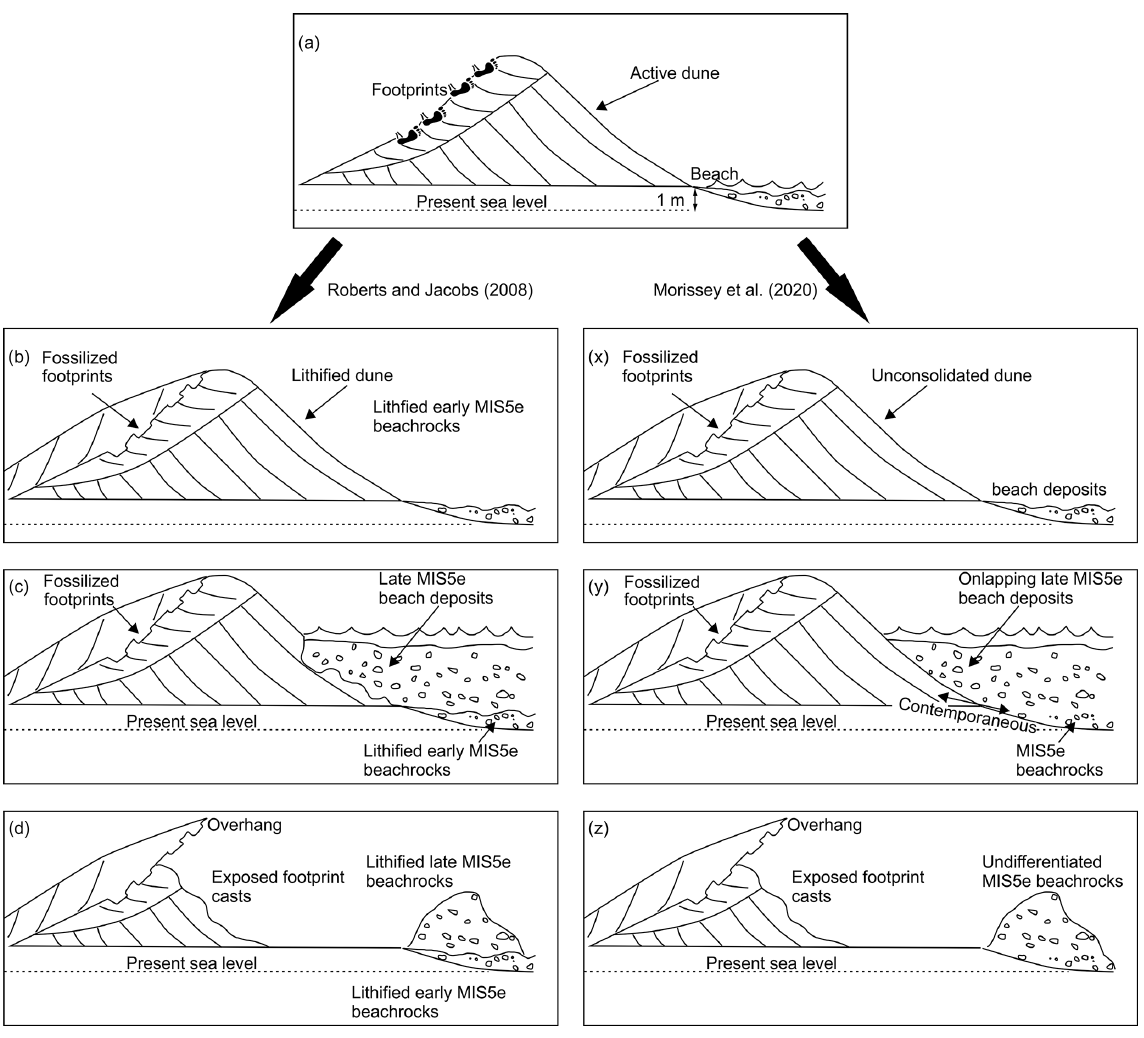
Figure 3. Diagrammatic sequence of depositional events and sea-level change associated with recorded hominid footprints on a fossil dune surface at Nahoon, East London. Two interpretations of the sequence are compared. In each, the starting point (a) is the same, but in the interpretation of Jacobs and Roberts (2009) (b–d) , the footprints are buried by further aeolian sedimentation, and the (undated) but supposed early MIS 5e dune/beach succession is lithified (b) , indicating that sea level had fallen by an unknown magnitude below the present level. In (c) a later (higher) MIS 5e highstand (to about ± 6m) partly erodes the earlier MIS 5e marine and aeolian deposits, and in panel (d) further erosion of the MIS 5e dune/beach succession occurs during the Holocene highstand, resulting in the development of an overhang, the underside of which bears the (natural) casts of the footprints. In the interpretation ( x – z ) of Morrissey et al. (2020), littoral sedimentation deposits an onlapping and conformable littoral unit during a continuously rising MIS 5e sea